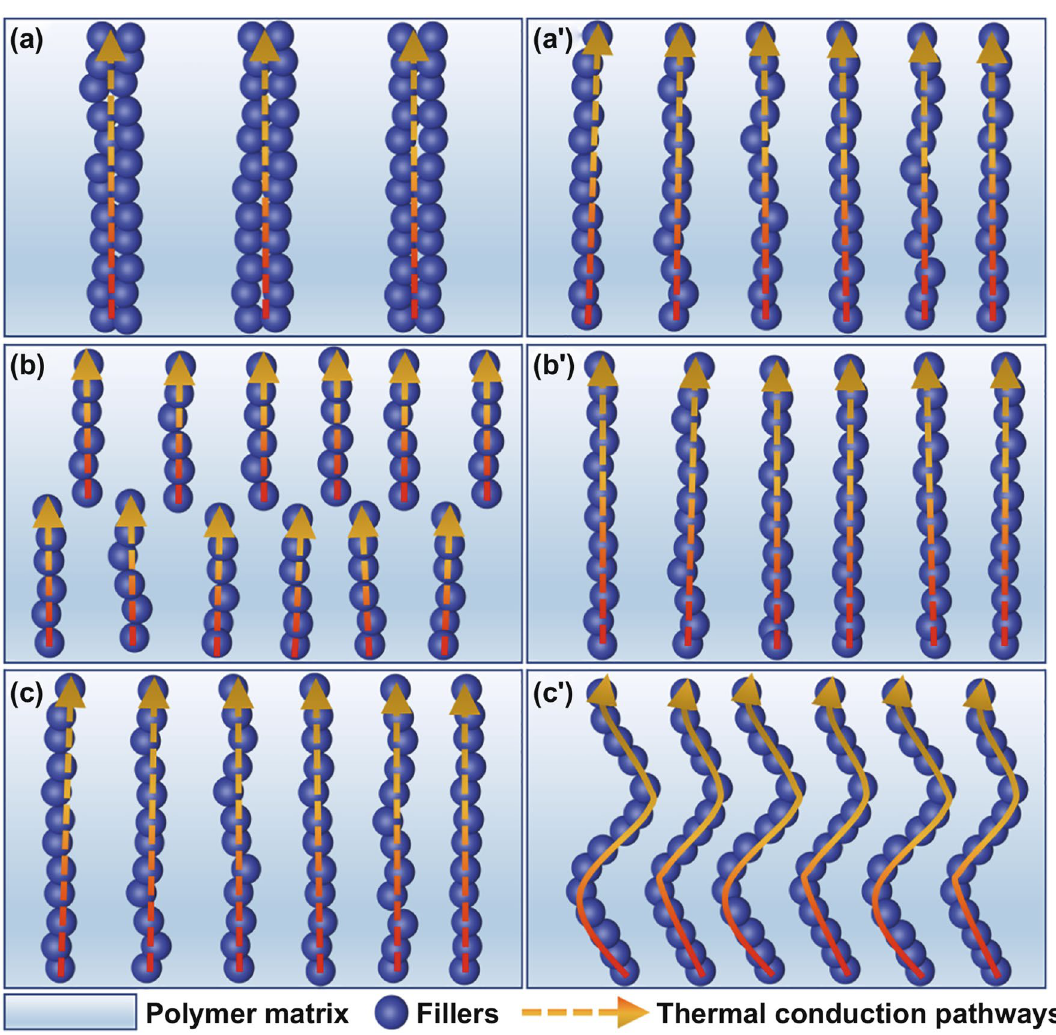
Fig. 4 Thermal conduction pathways in different numbers (fewer- a & more- a ′ ), different continuity (discontinuous- b & continuous- b ′ ) and dif- ferent length and shapes (short and straight- c & long and curved- c ′